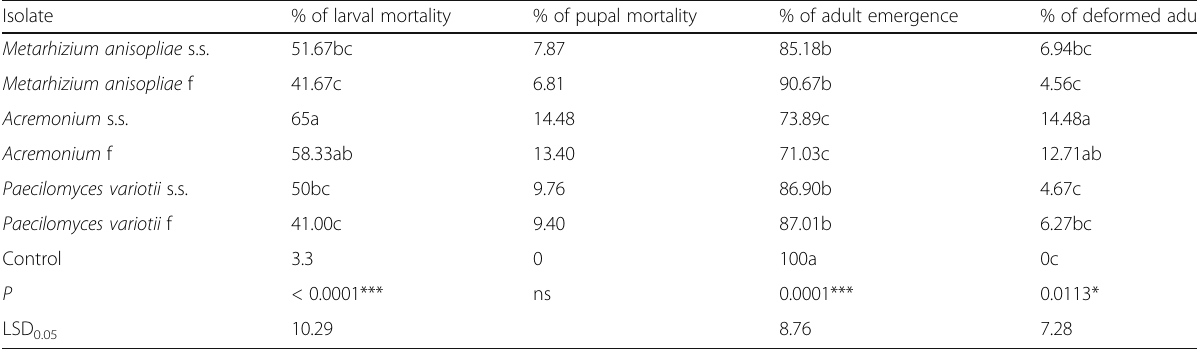
Table 1 Effect of some fungal isolates on larval, pupal and adult stages of the spiny bollworm Earias insulana Isolate % of larval mortality % of pupal mortality % of adult emergence % of deformed adult Metarhizium anisopliae